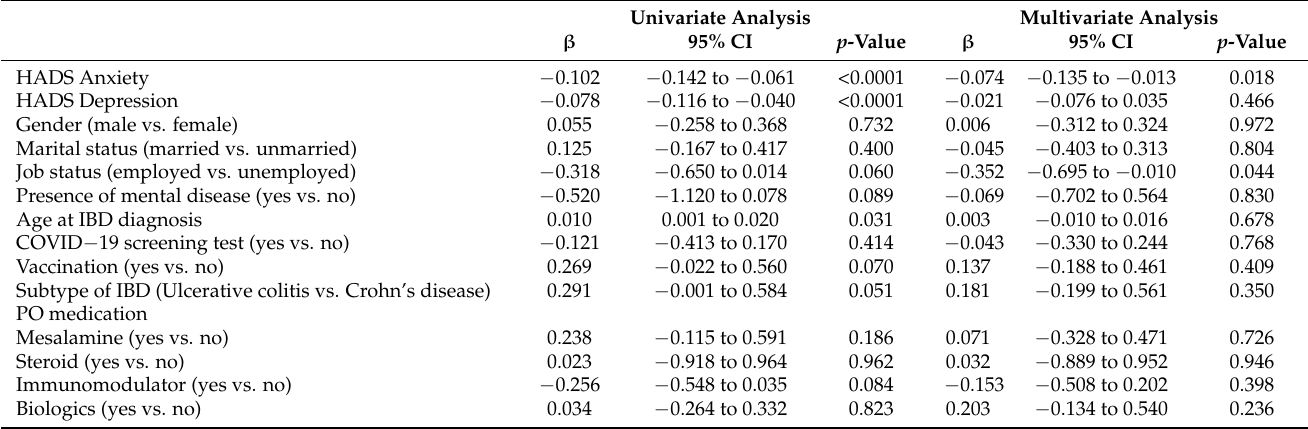
Table 4. Association between variables and Korean version of Medication Adherence Rating Scale